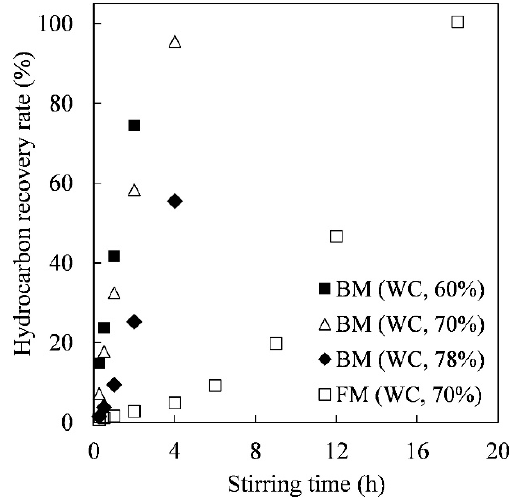
Figure 6. Hydrocarbon recovery rates from concentrated algal slurries of different water contents cultured in different media. FM: Freshwater medium, BM: Brackish medium, WC: Water content.